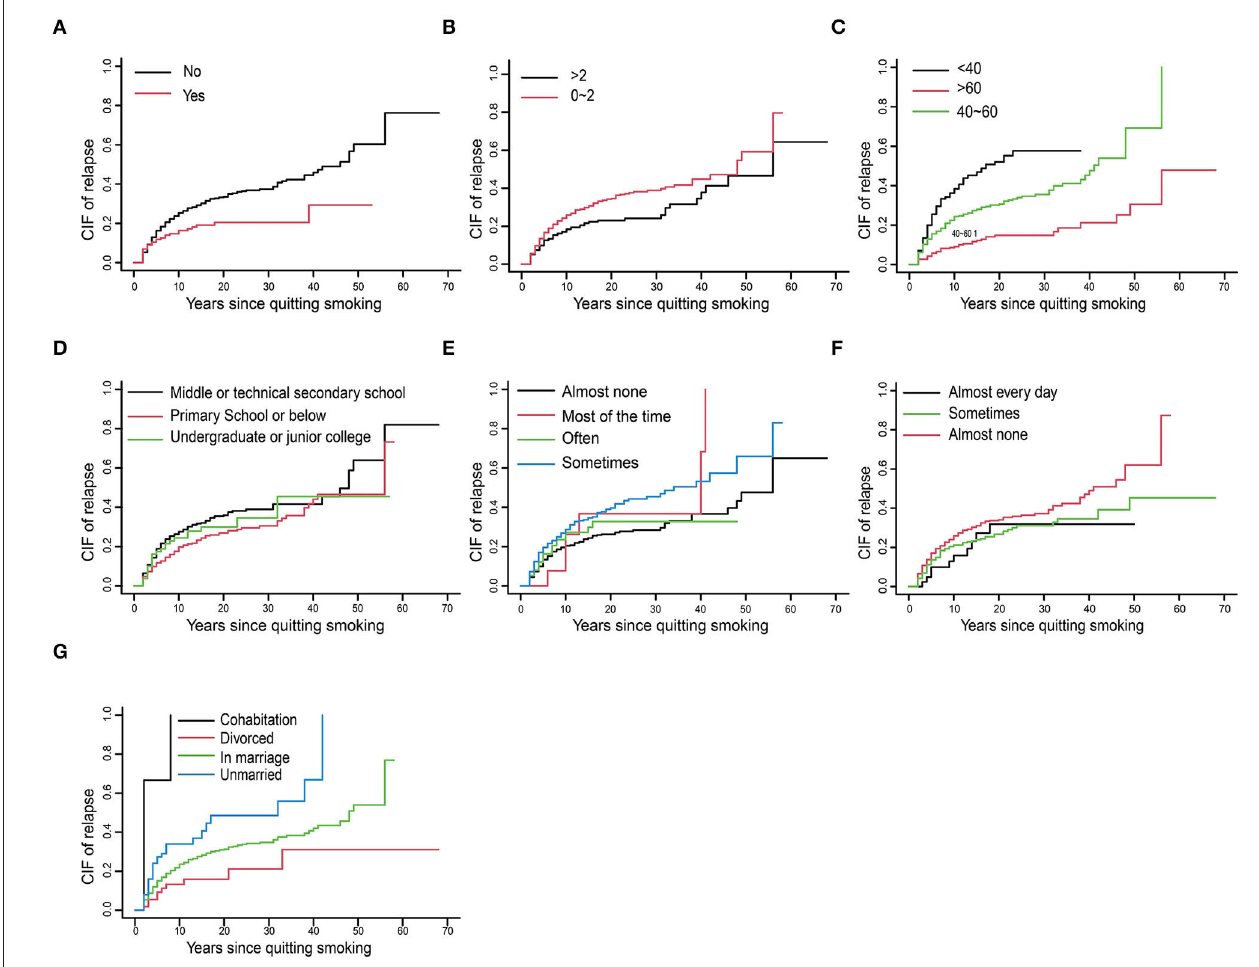
FIGURE 2 | The cumulative incidence function (CIF) of relapse in smokers with relapse as the end event. (A) Whether joined Chinese communist party. (B) Number of children. (C) Age. (D) Education level. (E) Depression frequency. (F) Exercise frequency. (G) Marital